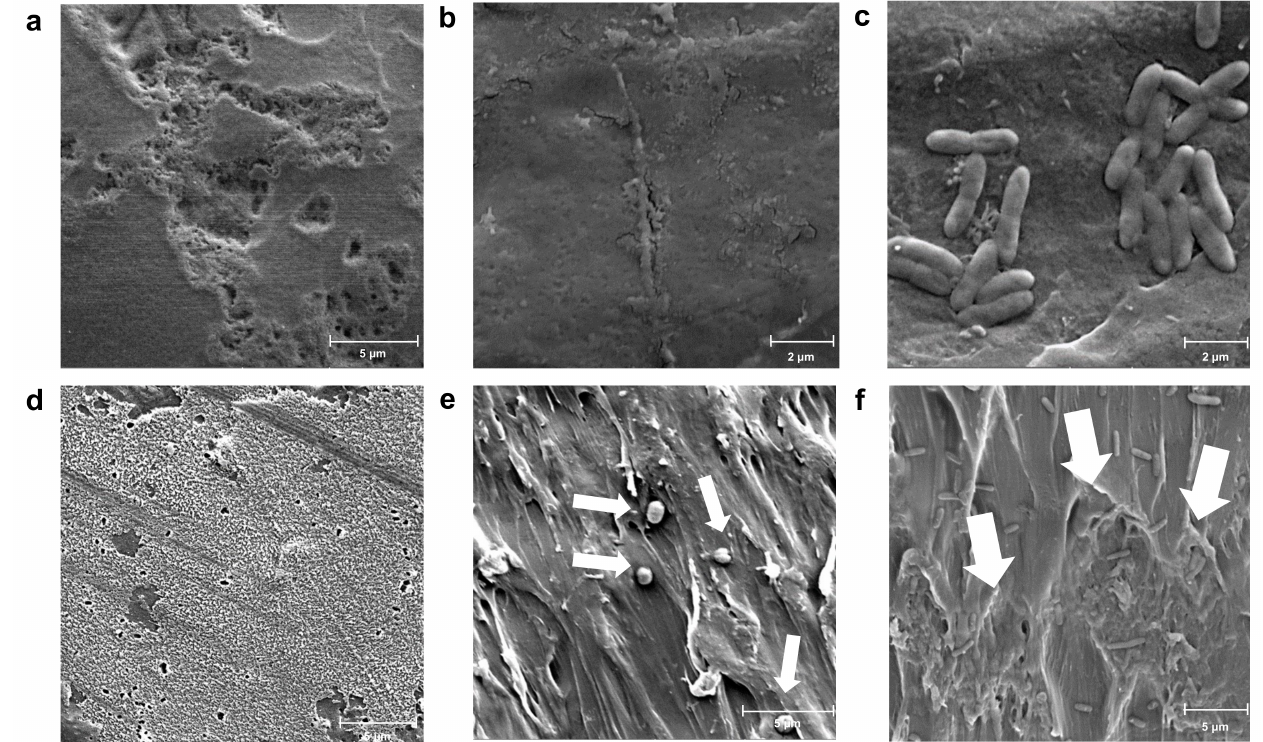
Figure 5. Styrofoam degradation by Exiguobacterium sp. RIT 594. PS was obtained directly from Styrofoam coffee cups (US size small) for ( a – c ). ( a ) Uninoculated control (9930 × resolution, scale bar 5 µ m). ( b , c ) 35-day old cultures containing Styrofoam pieces (17,700 × resolution, scale bar 2 µ m, and 17,700 × resolution, scale bar 2 µ m, respectively). Note how the biofilm is sparse in contrast to earlier examples and in the cells seen in Figure 2c,d,g,h; ( c ) cells are fattened and elongated, suggesting starvation. ( d – f ) PS in the form of transparent flakes dissolved in toluene and dried inside a fume hood to remove the solvent. ( d ) An uninoculated control; ( e , f ) 35-day old cultures containing PS flakes. Cells are either embedded on the surface as cocci ( e ) or congregate as short rods inside the polymer ( f ) (see white arrows), a morphology also seen in Figure 4h. ( d – f ) Resolutions are 8790, 10,300, and 7350 × , respectively, and the scale bars are 5 µ